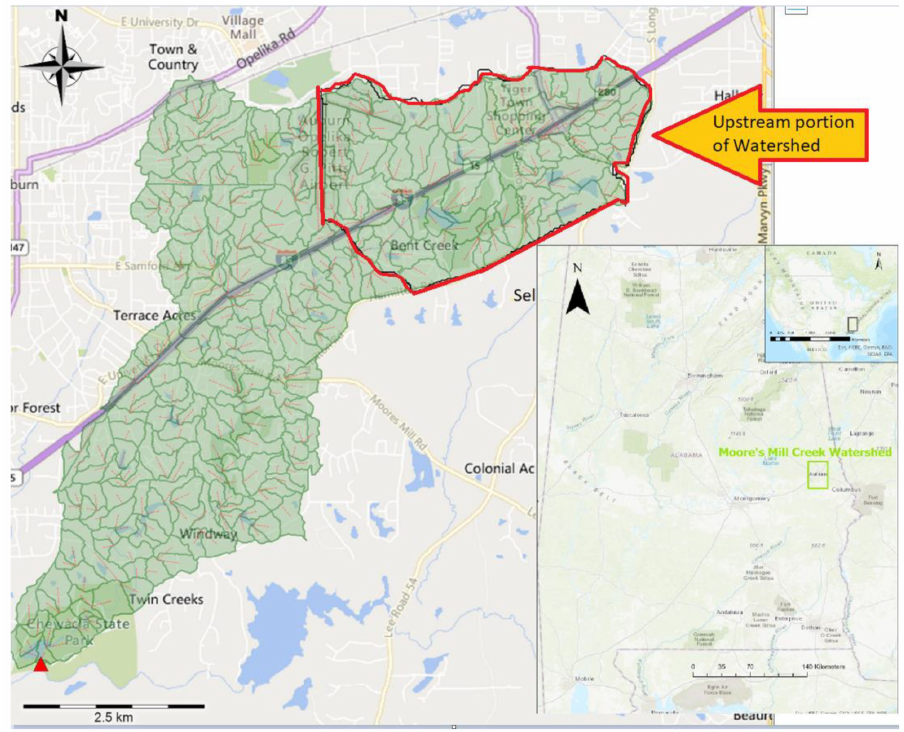
Figure 1. Moore’s Mill Creek watershed, located in east Alabama, USA. The area selected for this research is delineated in